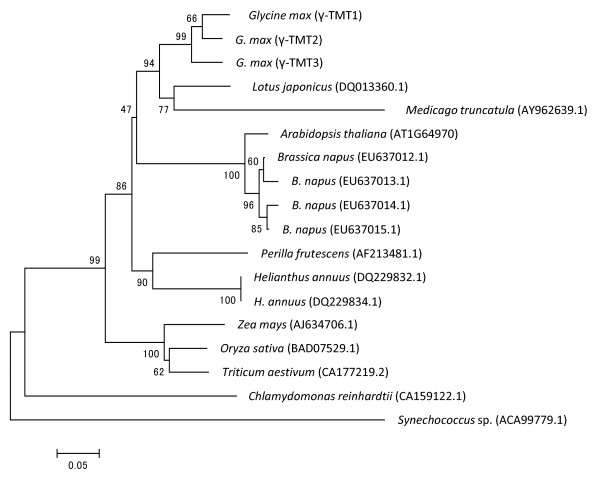
Neighbor-joining phylogenetic tree of γ-TMT proteins. Comparison of the deduced amino acid sequences of γ-TMT1, γ-TMT2, and γ-TMT3 from soybean with γ-TMTs of plants, green algae and cyanobacteria. GenBank accession numbers are shown in parentheses. An unrooted tree based on amino acid sequence similarity was obtained by using the neighbor joining method. Bootstrapping was performed with 1,000 replicates, and the bootstrap values (percent) are indicated above the supported branches. The scale bar indicates the distance corresponding to 5 changes per 100 amino acid positions. The predicted protein sequences were initially clustered by using ClustalW.